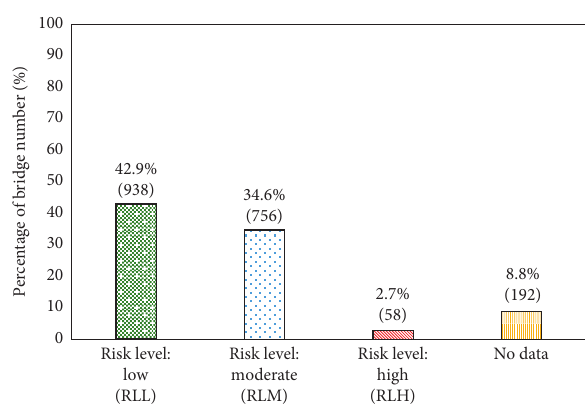
Figure 5: Results of occurrence.